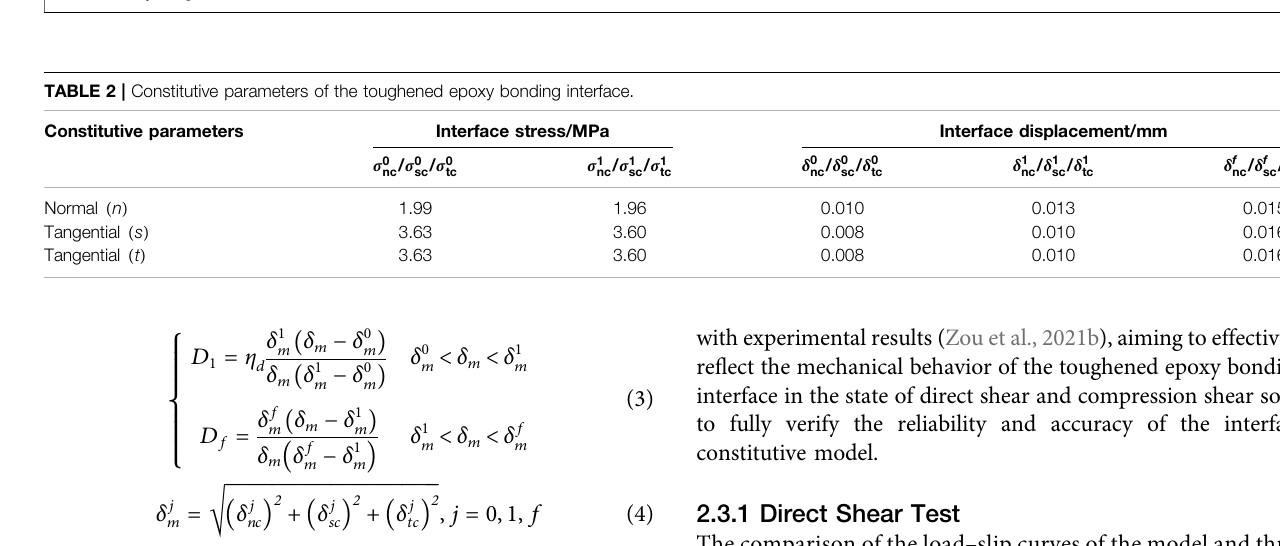
FIGURE 2 | Toughened-friction interfacial constitutive model.